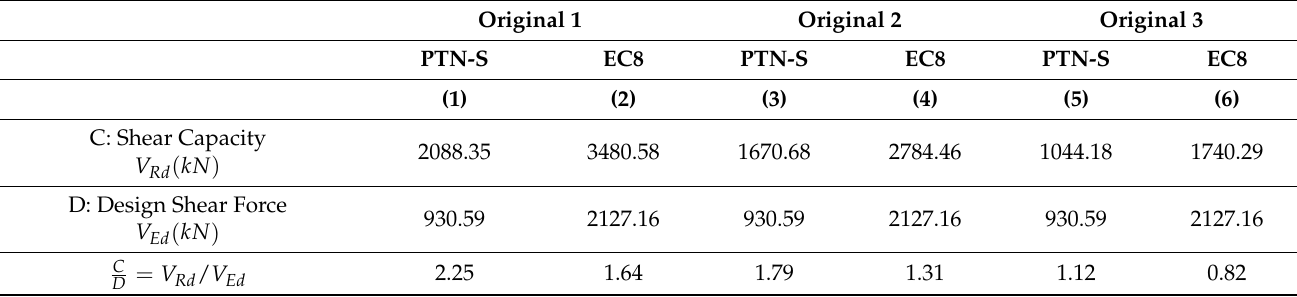
Table 6. Comparison of seismic capacity (C) and demand (D) at the ground floor level of the building in E–W direction (for the original structure).